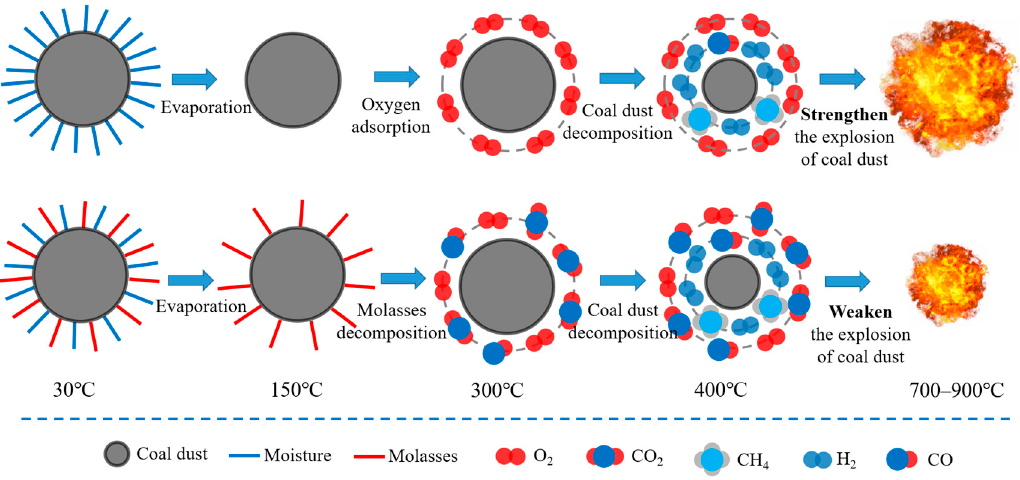
Figure 12. Schematic diagram of the in fl uence of molasses on the coal dust explosion.